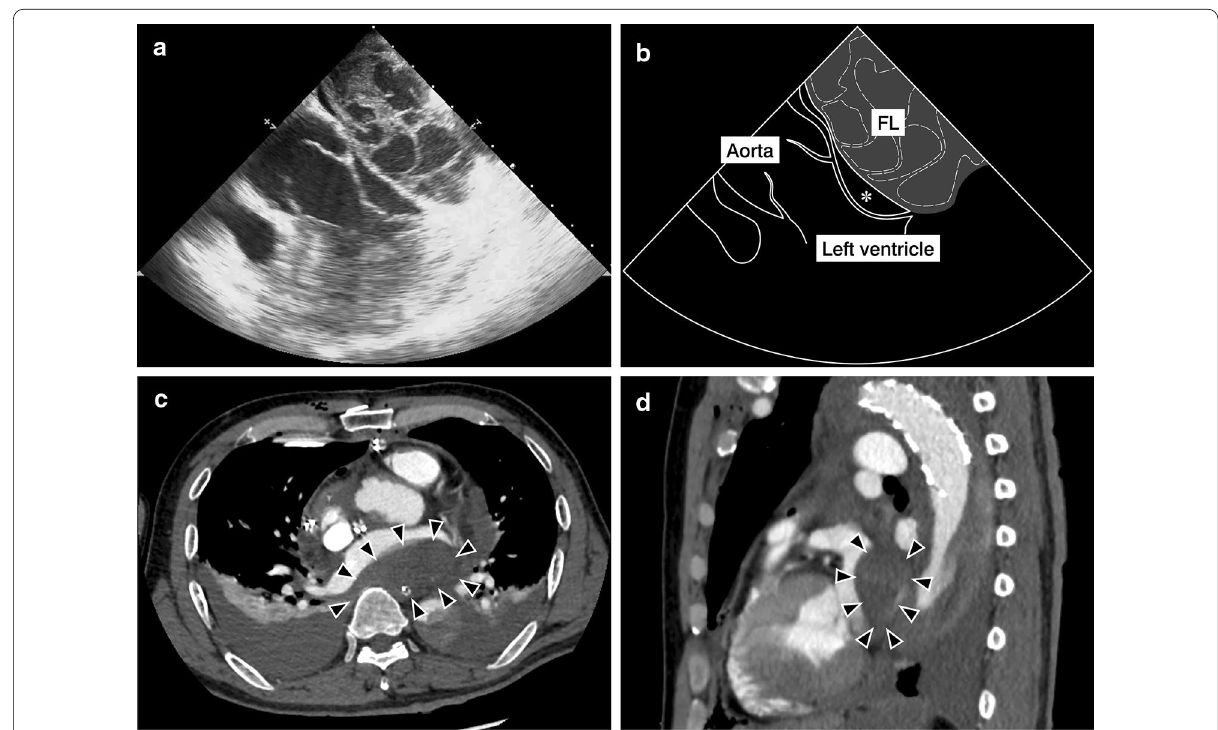
Fig. 1 Intra- and postoperative imaging findings. a Transesophageal echocardiography showing a multivesicular space on the back of the left atrium that has no significant fistula with the left atrium. b A schema of the transesophageal echocardiography findings. The grayed area indicates false lumen (FL) of the left atrium. The true lumen of the left atrium (asterisk) is compressed by the FL. c , d Enhanced computed tomography ( c axial view, d sagittal view) immediately after surgery showing a non-enhanced space on the back of the left atrium (arrowheads) that is not connected with the left